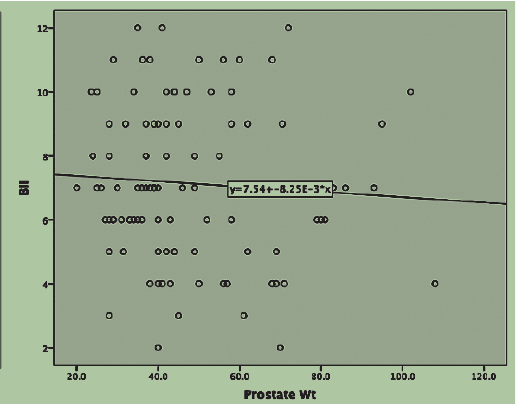
Figure 5. Scatter diagram showing correlation between Wt of Prostate and BPH II